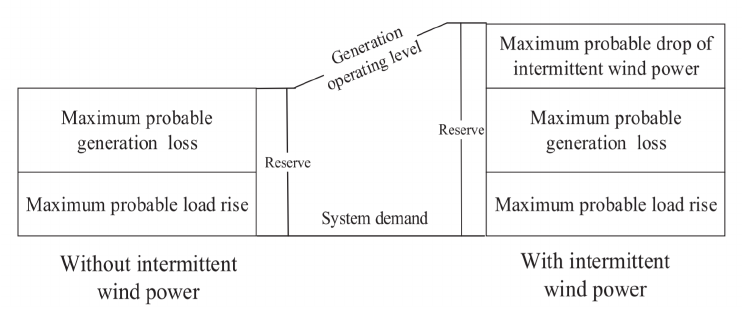
Figure 2. Impact of RES intermittency on the reserve amount of the power system [34], modified by [35], reproduced with permission from